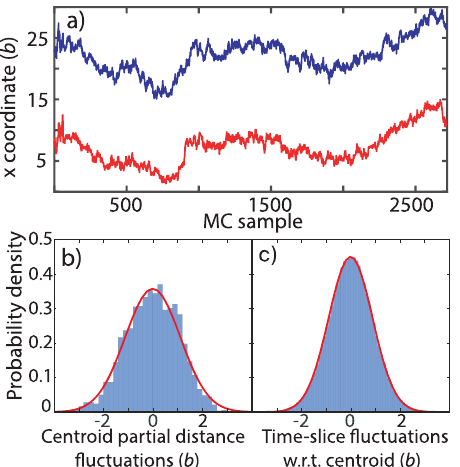
Fig. 2 Partial-dislocation centroid positions and fl uctuations and time-slice fl uctuations without impurities. a Centroid x -positions of both partials along PIMC run in pure 4 He system at T = 0.267 K, in units of the perfect Burgers vector b = 3.667 Å . b Histogram of fl uctuations in partial separation obtained from centroids in a ). c Histogram of atomistic time-slice-deviations with respect to centroid for partials using Fourier-smoothed paths (see Supplemen- tary Note 2). Red lines in b ) and c ) represent results for effective 1D model in Eq.